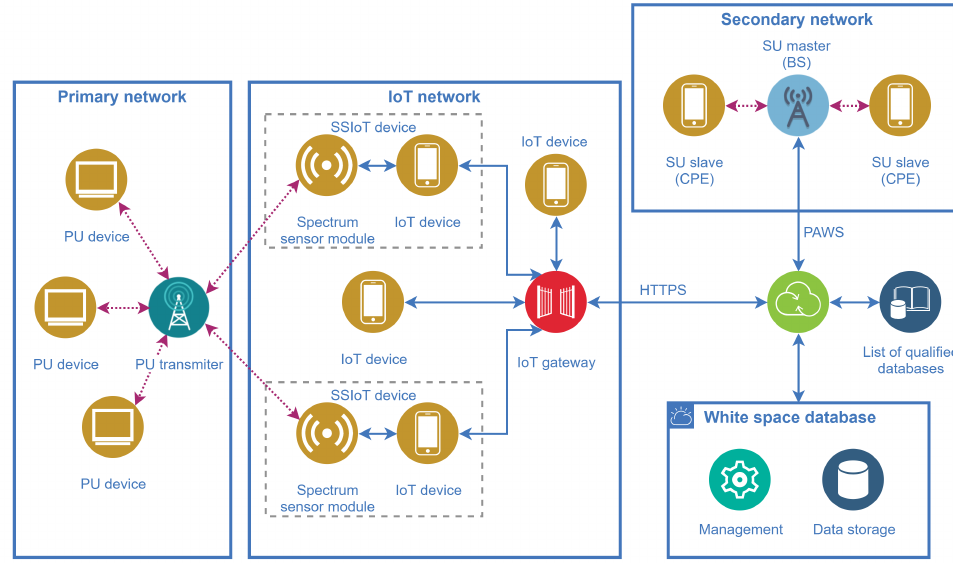
Figure 5. Main entities and their relationships in the database-driven IoT-enabled dynamic spectrum access framework.